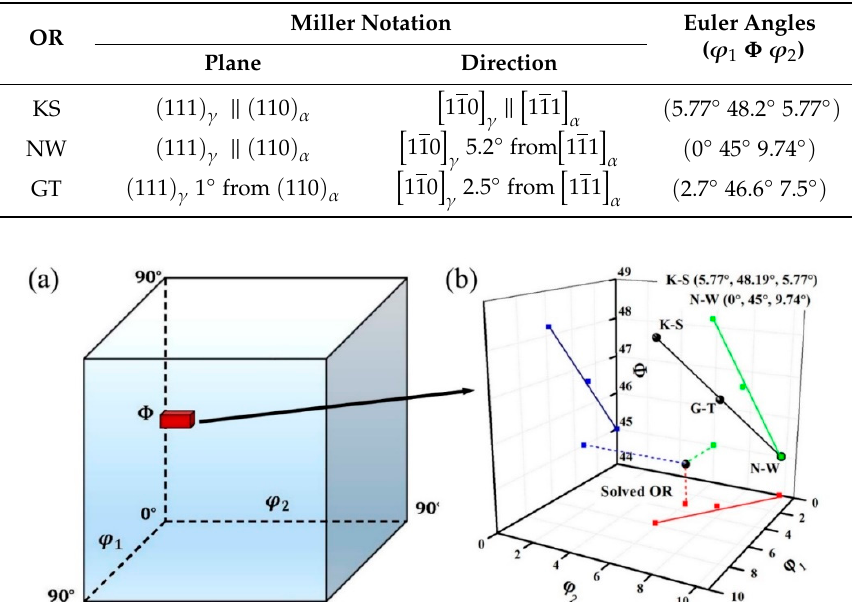
Table 1. Miller notations and the corresponding Euler angles for different classical orientation relationships (ORs) [15].